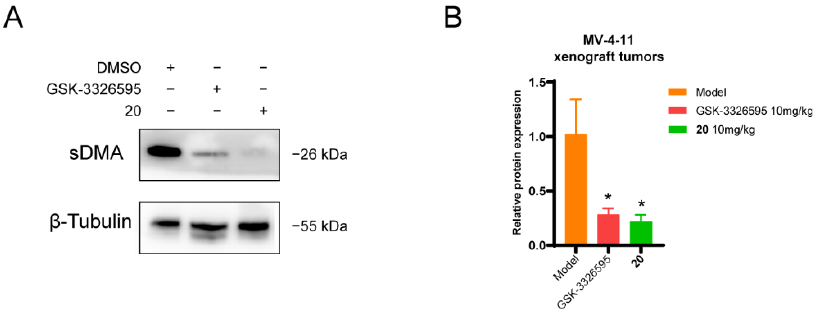
Figure 8. PRMT5 substrate sDMA expression of GSK-3326595 (10 mg · kg − 1 , iv) and compound 20 (10 mg · kg − 1 , iv) treatment for the tumorigenicity of MV-4-11 cells in vivo. ( A ) Western blot analysis of sDMA as indicated in MV-4-11 xenograft tumors treated with the indicated compounds for 28 days. ( B ) The relative strength of sDMA signal on the Western blots was measured by densitometry. The data are shown as the mean ± SD of three independent experiments. * p < 0.05 vs.